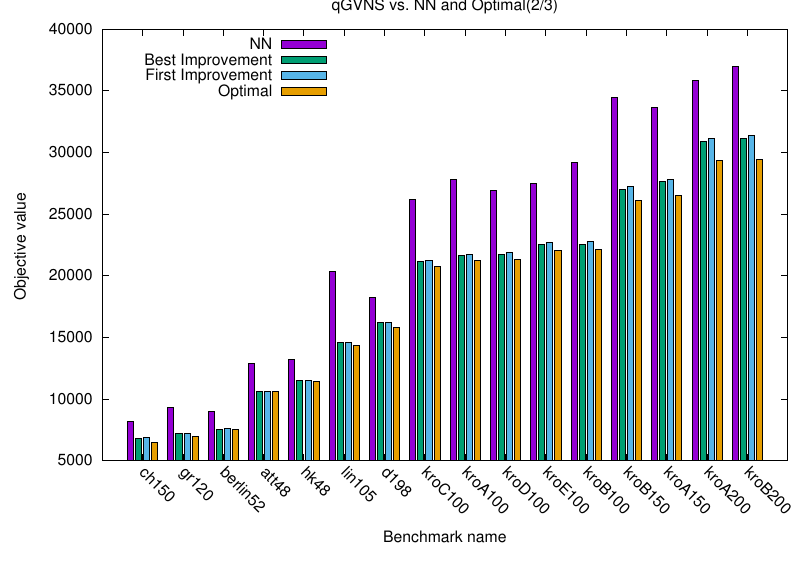
Figure 2. NN vs. GVNS vs. OV (2/3).